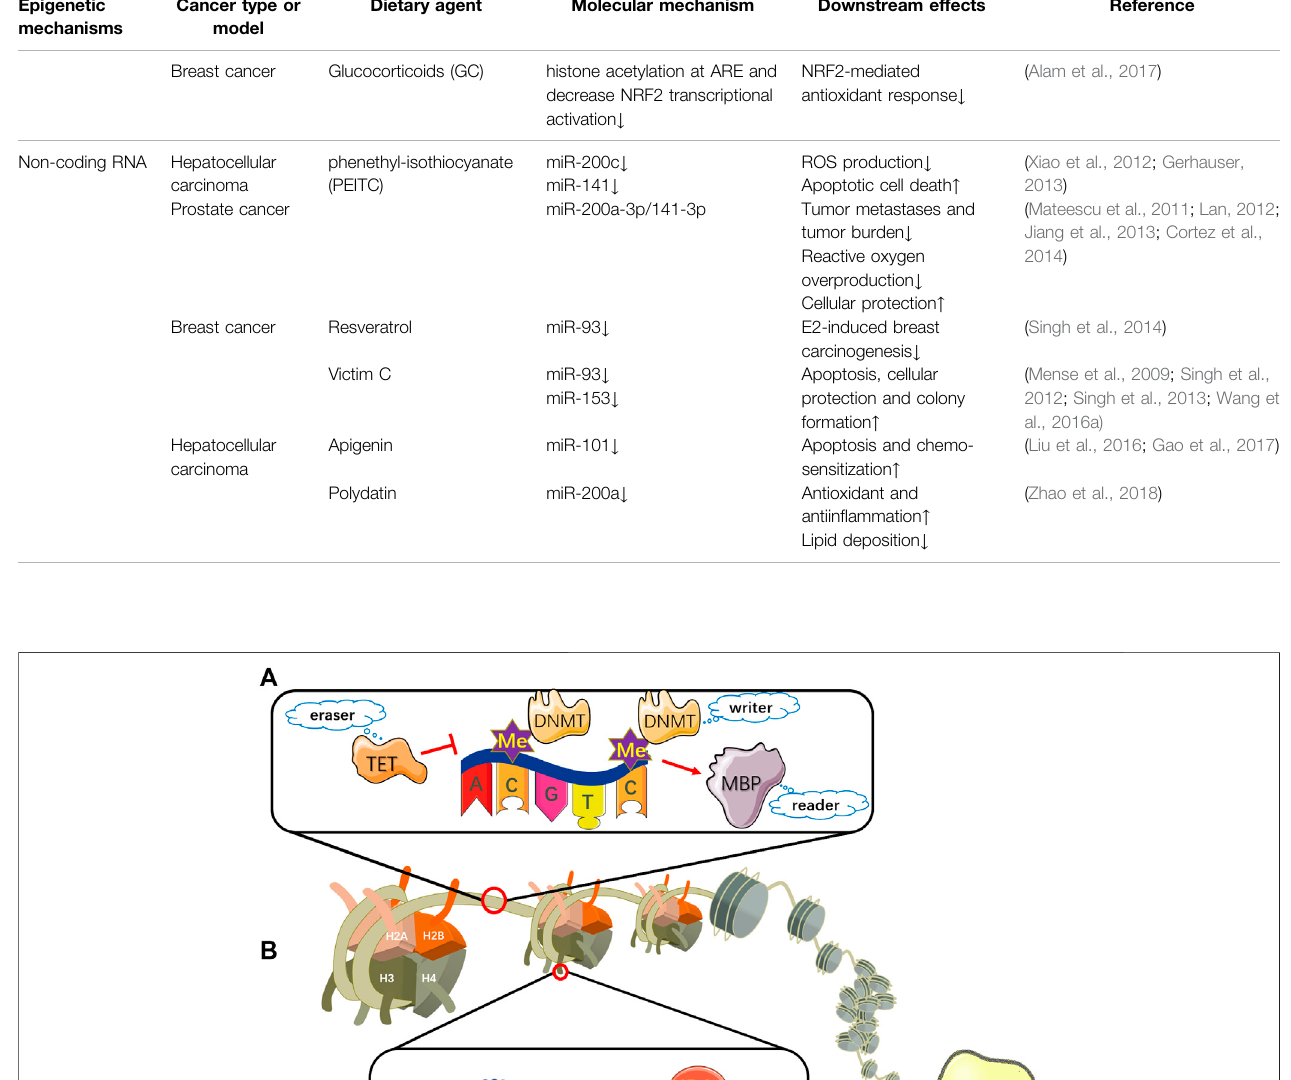
Frontiers in Pharmacology |